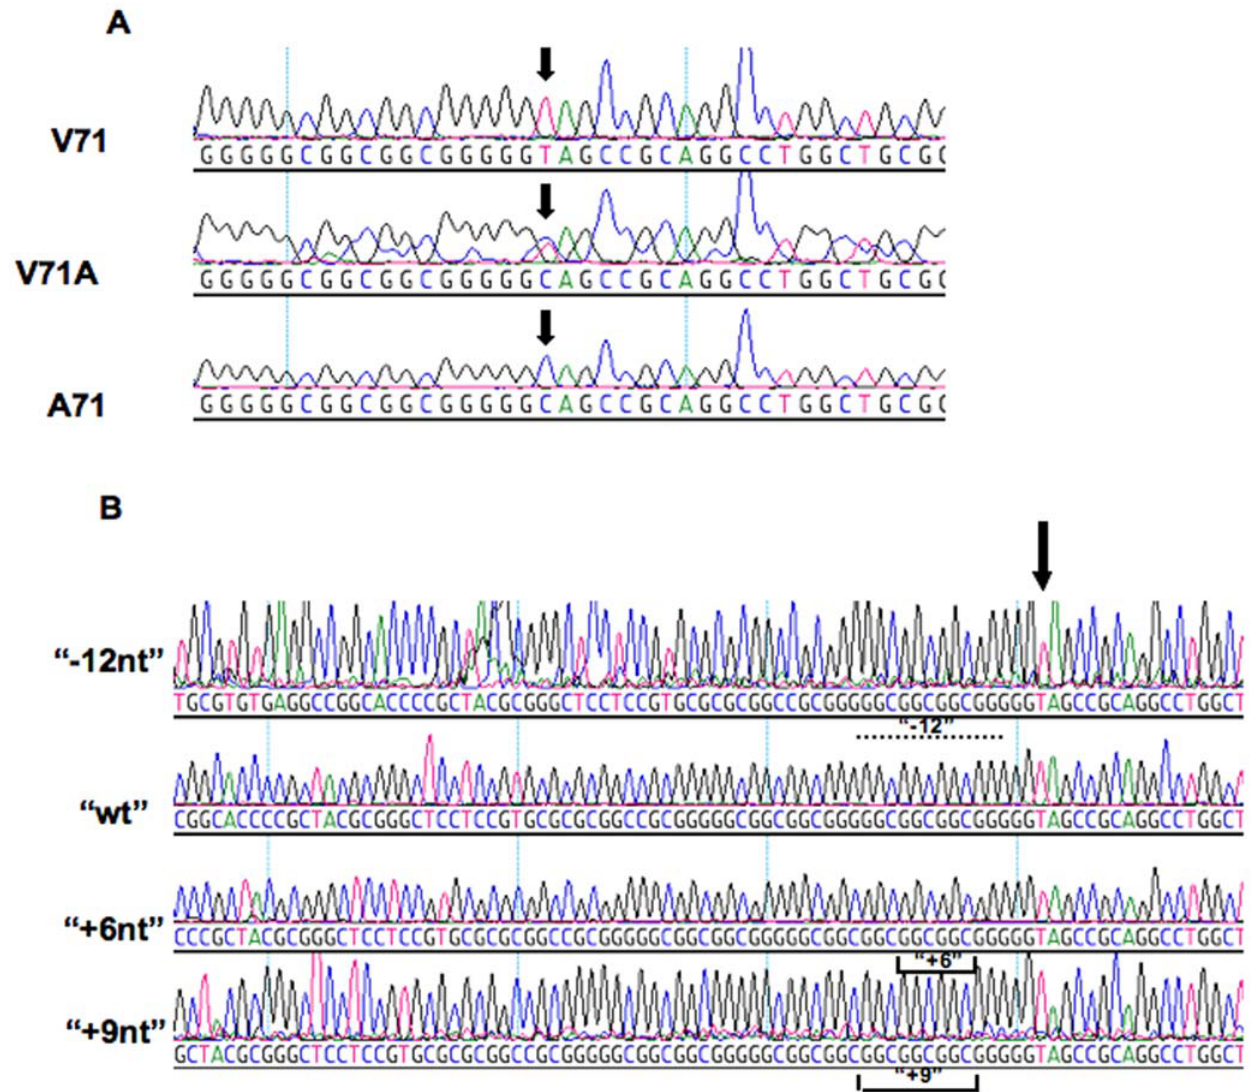
Figure 3. Sequences of Different Sheep SPRN alleles. (A) Electrophoregrams presenting the polymorphism V71A. Codon 71 is either GTA (Val) or GCA (Ala). (B) Electrophoregrams of sequencing reactions from cloned PCR products, representing a deletion of 12 bases, or insertions of either 6 or 9 bases relative to the wild type prototype.